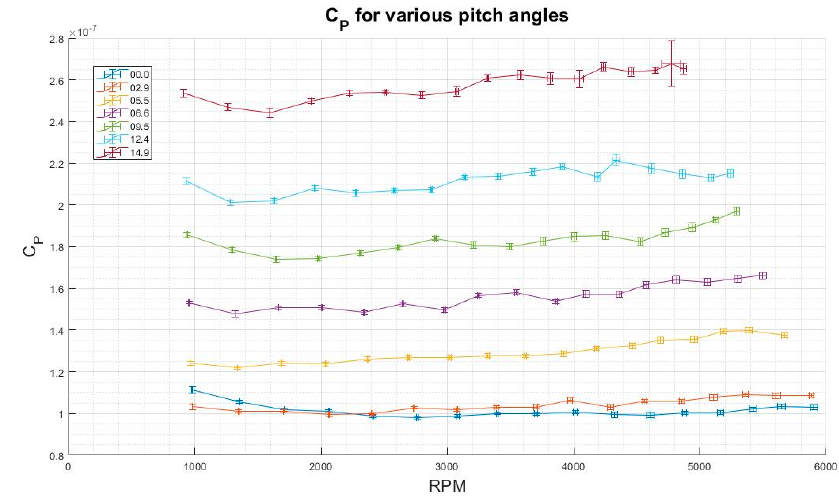
Figure 6. Coe ffi cient of power ( C P ) for various pitch angles. Figure 6. Coefficient of power ( C P ) for various pitch angles. Figure 6. Coefficient of power ( C P ) for various pitch angles.